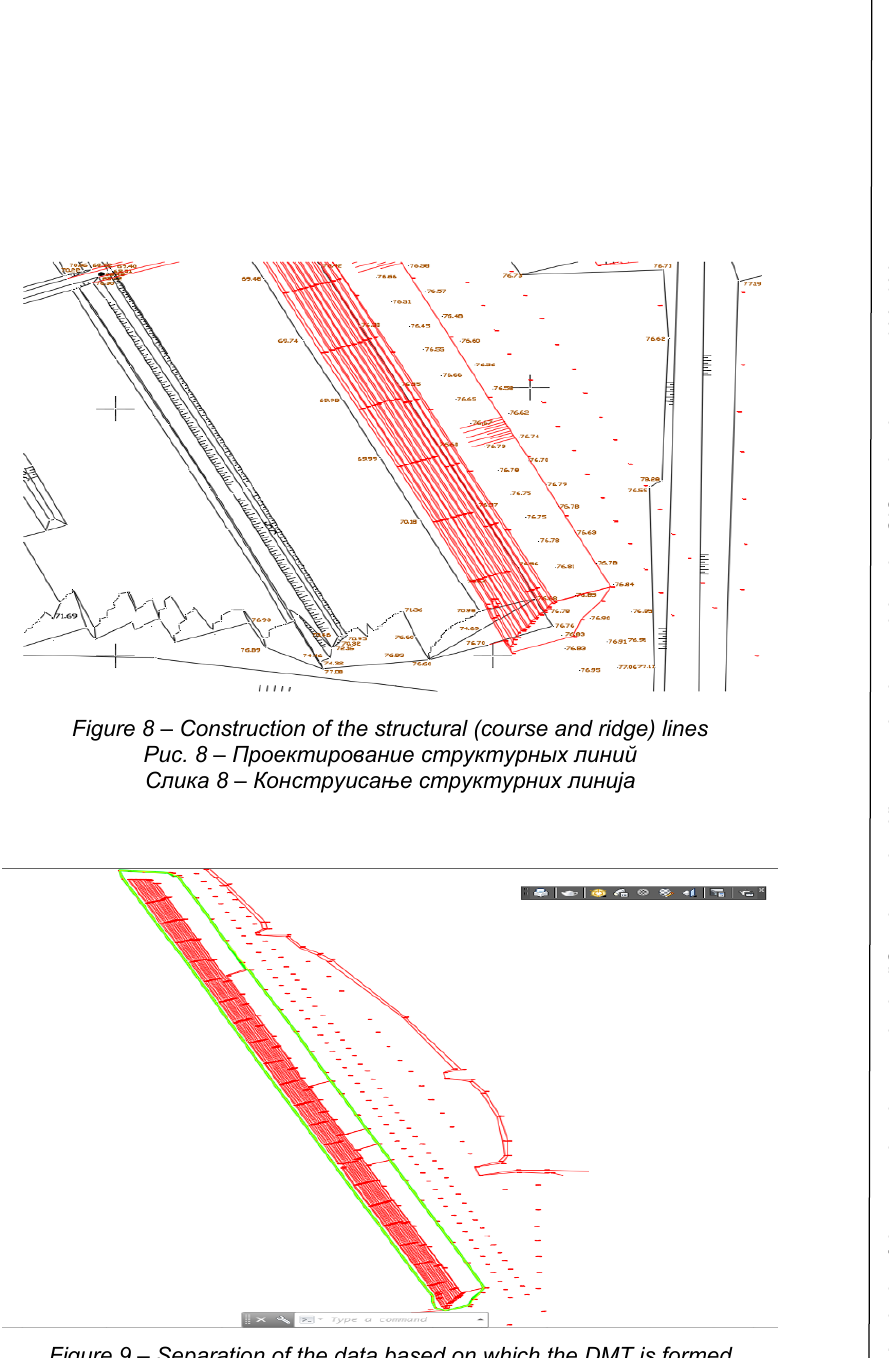
Figure 9 – Separation of the data based on which the DMT is formed Рис . 9 – Выделение данных на основании которых создается ЦММ Слика 9 – Издвајање података на основу којих се формира ДМТ This sort of data is saved as a new . dwg file, which is processed further